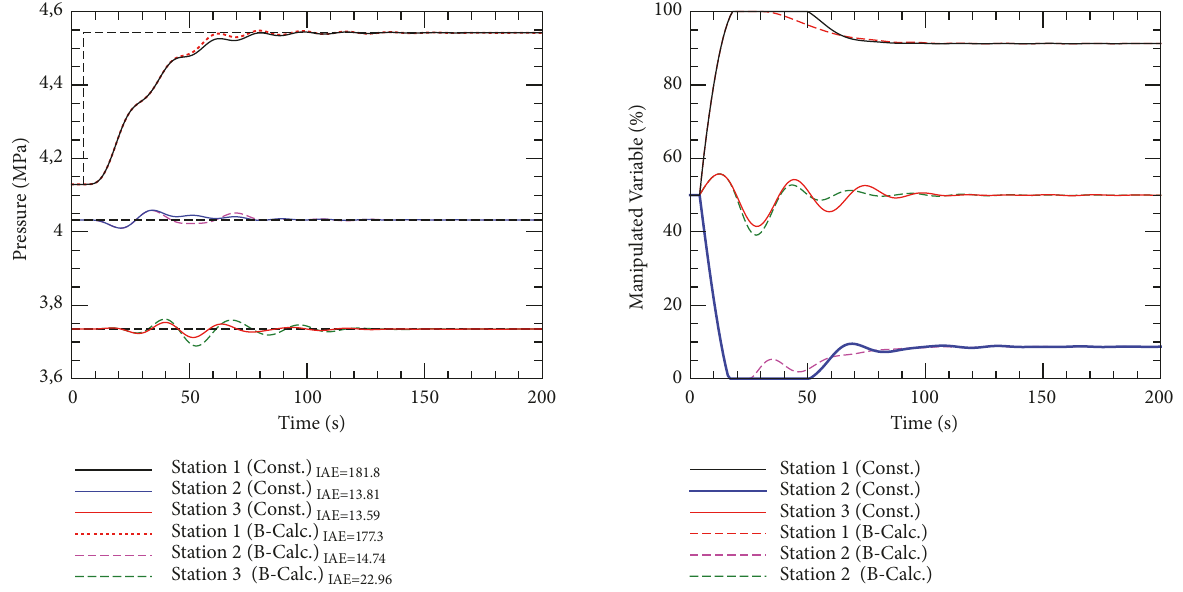
Figure 6: Performance comparison between the Constrain and the Back-Calculation